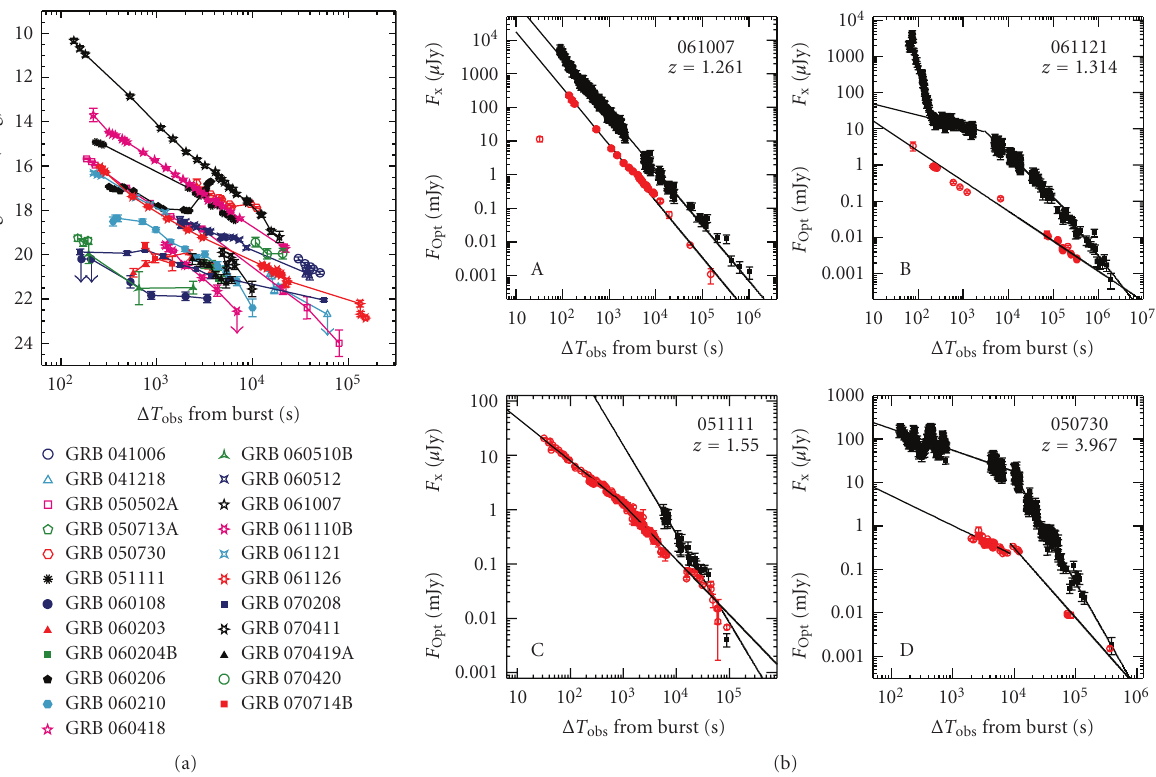
Figure 4: (a) Selection of early-time optical light curves from the Liverpool and Faulkes telescopes. (b) Examples of X-ray (black) and optical (red) light curve comparisons leading to classification scheme using synchrotron model breaks